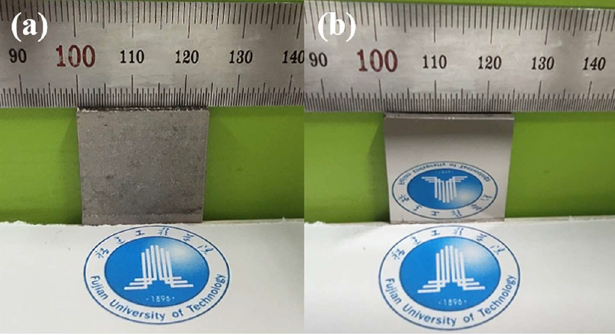
Fig. 10. Comparison before and after polishing: (a) before, (b)